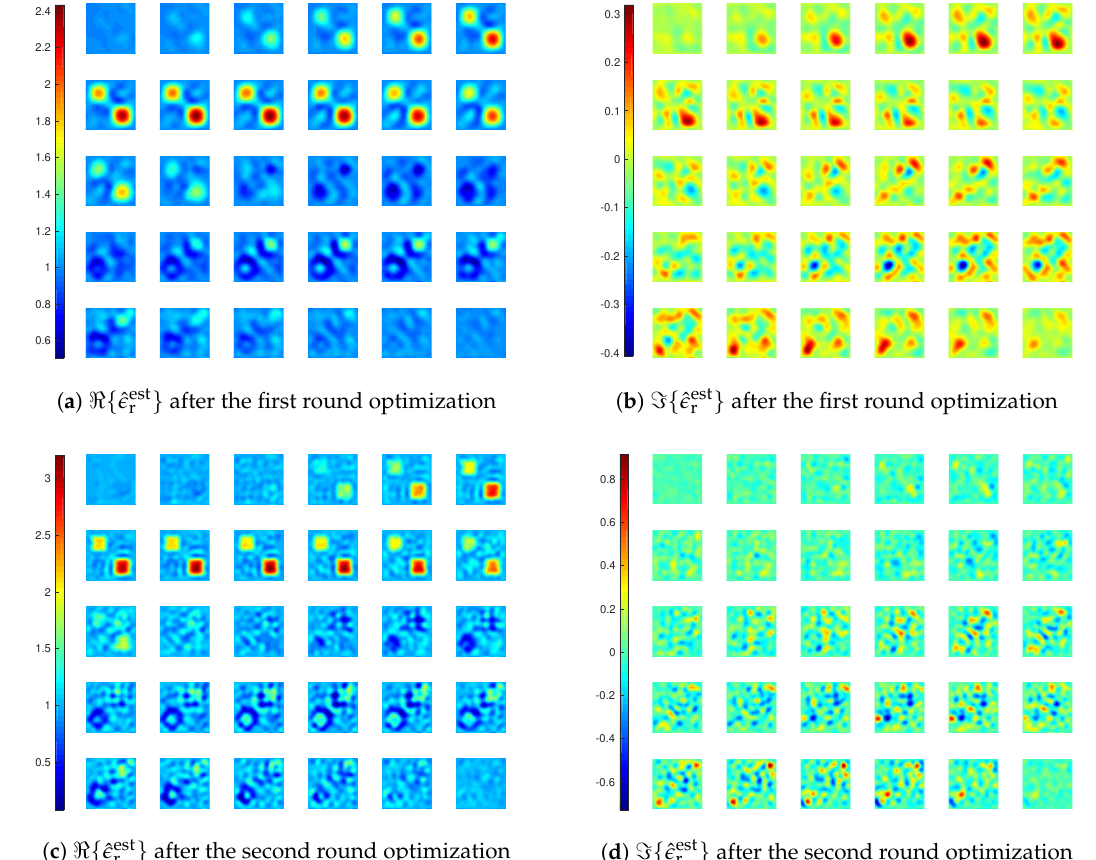
Figure 8. Reconstruction results of inversions with LSIE for Example 2 .